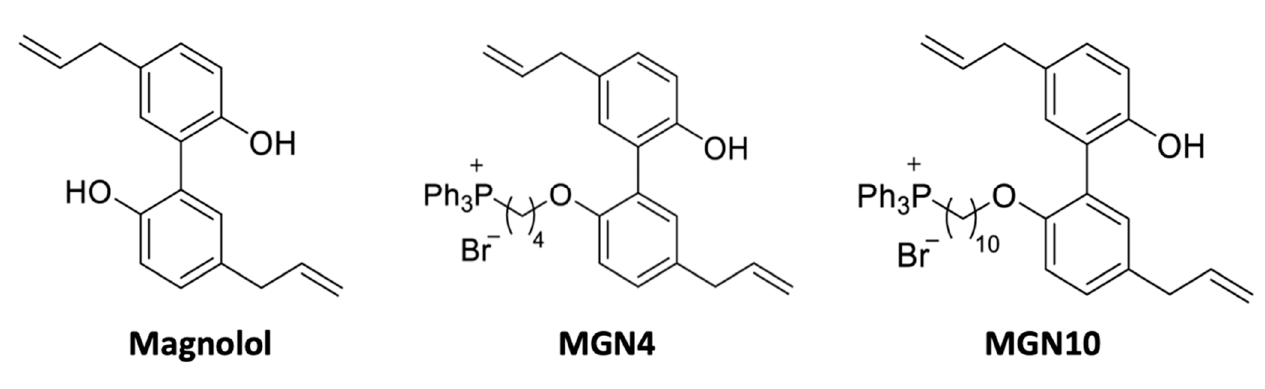
Figure 6. Chemical structure of compounds. MGN4 and MGN10 refer to a TPP+ moiety conju- gated to MGN (Magnolol) via a 4- and 10-carbon alkyl side chain, respectively [30]